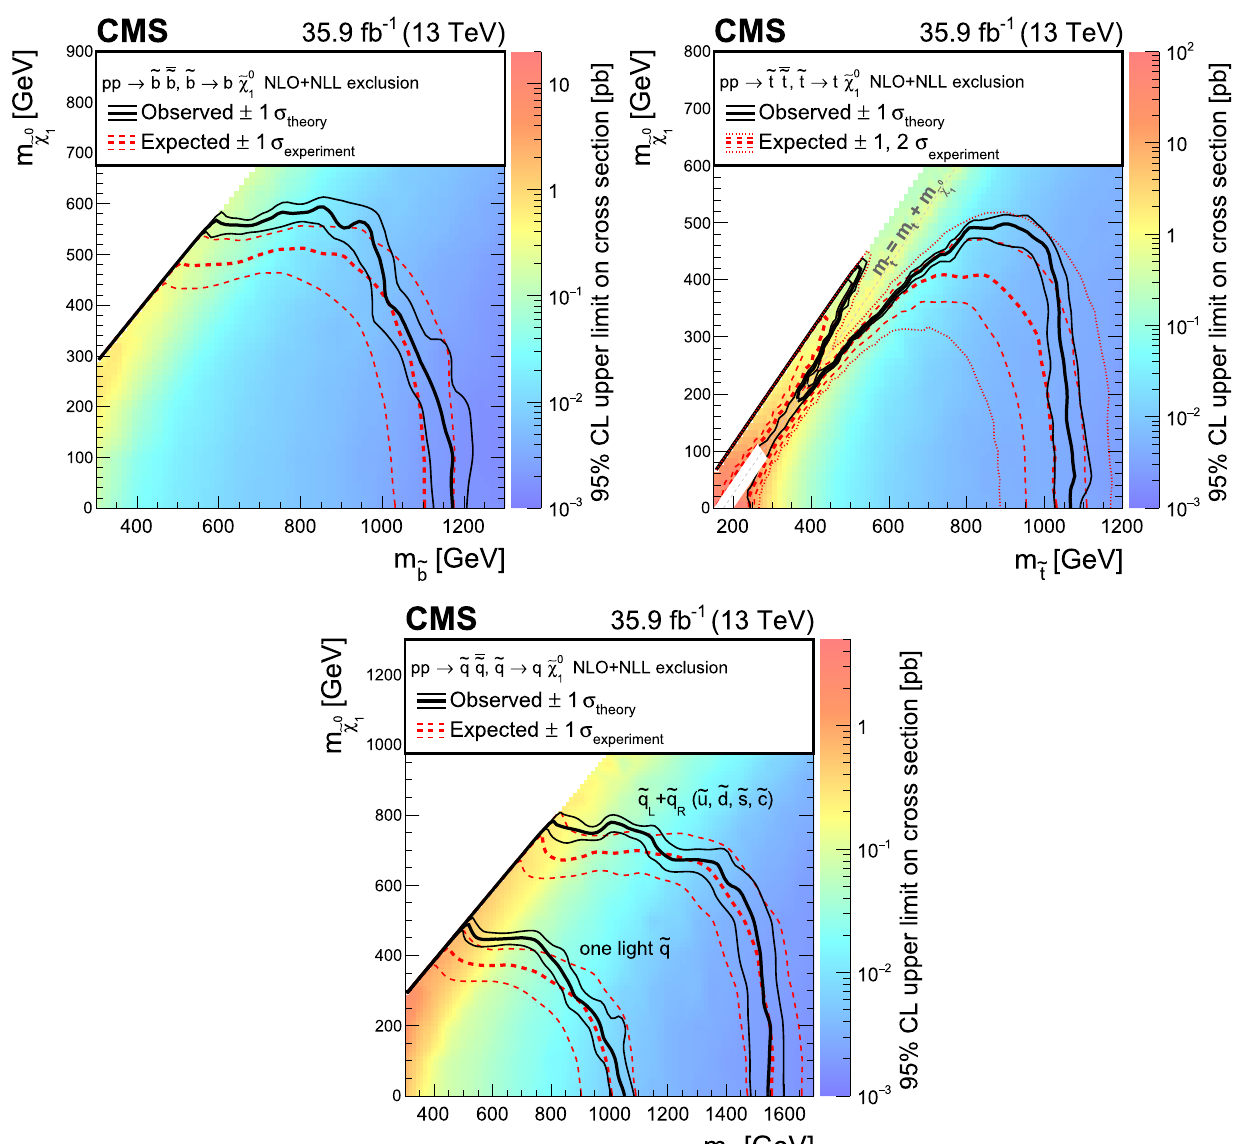
Fig. 7 Exclusion limit at 95% CL for bottom squark pair production (upper left), top squark pair production (upper right), and light-flavor squark pair production (below). The area enclosed by the thick black curve represents the observed exclusion region, while the dashed red linesindicatetheexpectedlimitsandtheir ± 1standarddeviationranges. Forthetopsquarkpairproductionplot,the ± 2standarddeviationranges are also shown. The thin black lines show the effect of the theoretical